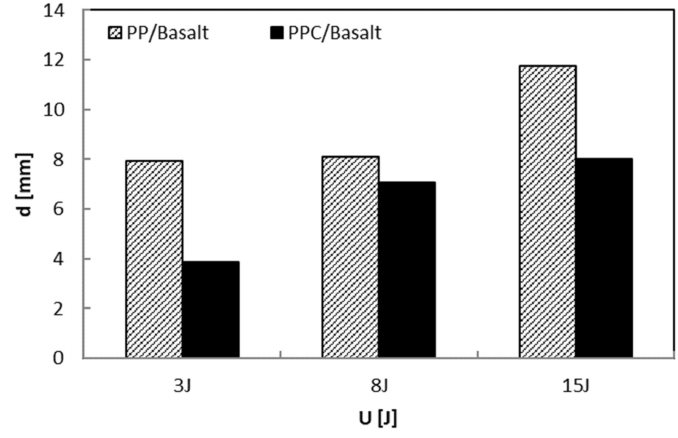
Figure 12. Maximum deflection, d, versus impact energy, U.